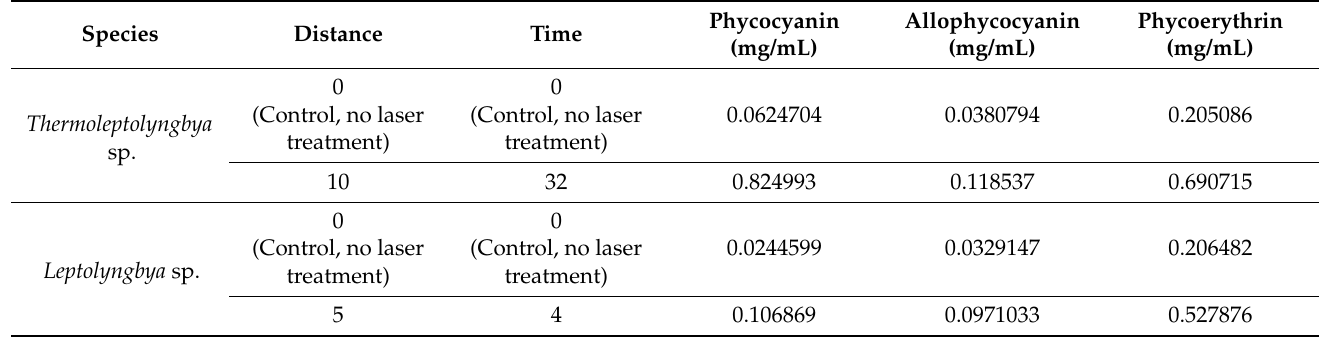
Table 3. The phycobiliprotein pigments concentration of extracts before and after to laser exposure of Thermoleptolyngbya sp. and Leptolyngbya